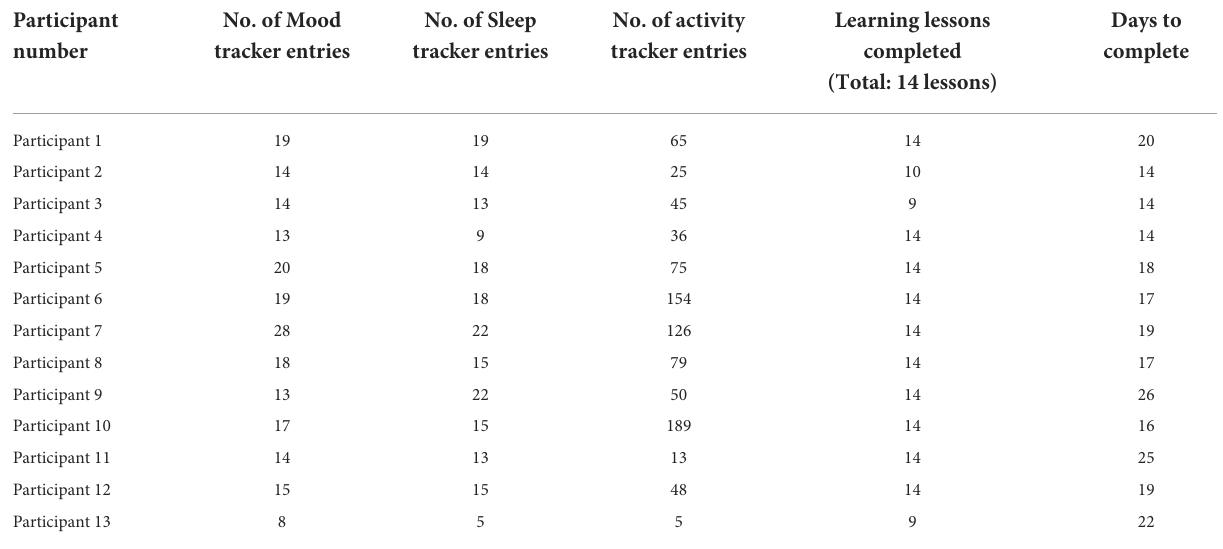
TABLE 2 Device data